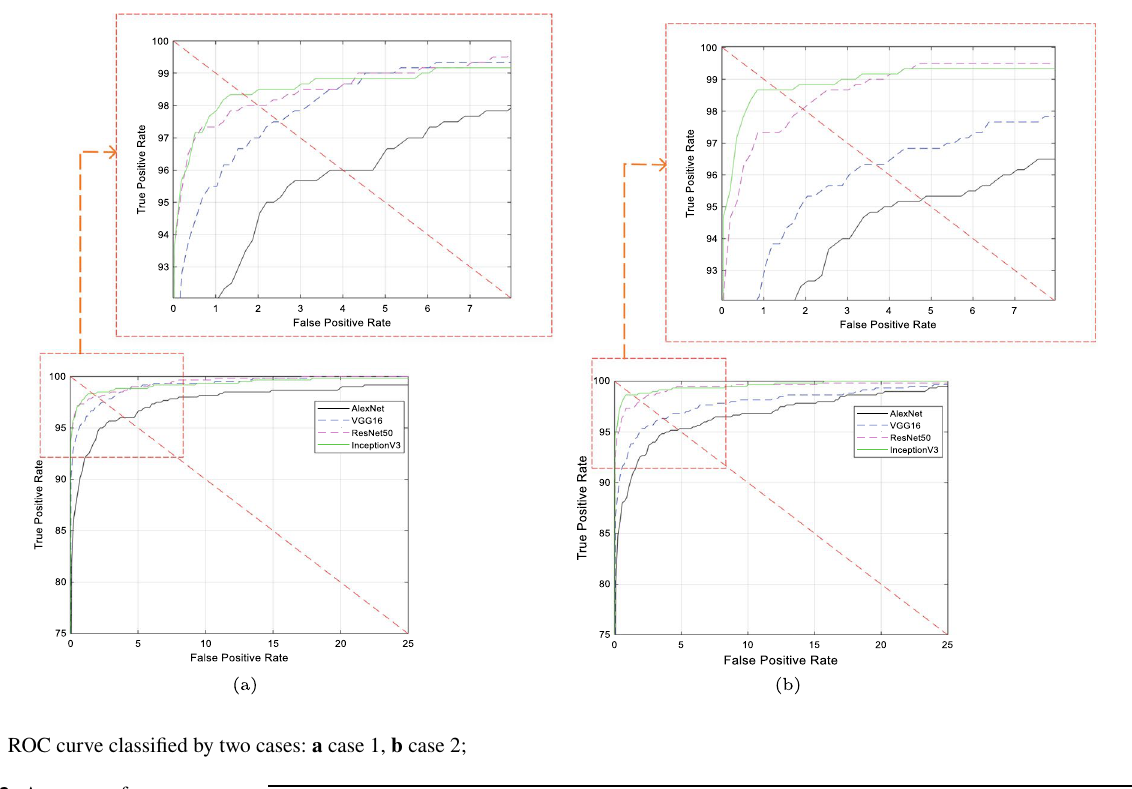
CNN model Original iris Geometric trans- HISTEQ Proposed method HISTEQ + image formations